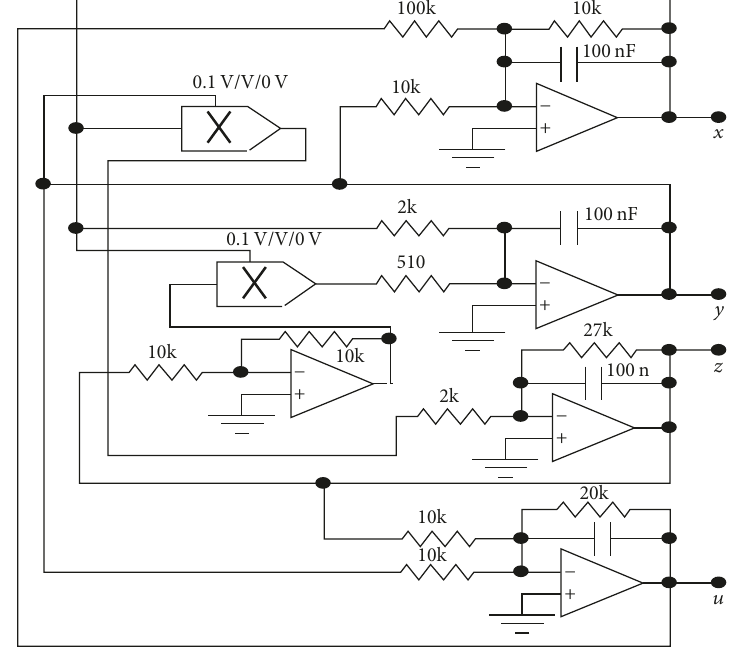
Figure 5: (𝑦 + 𝑧) - 𝑢 - 𝑥 hyperchaotic circuit